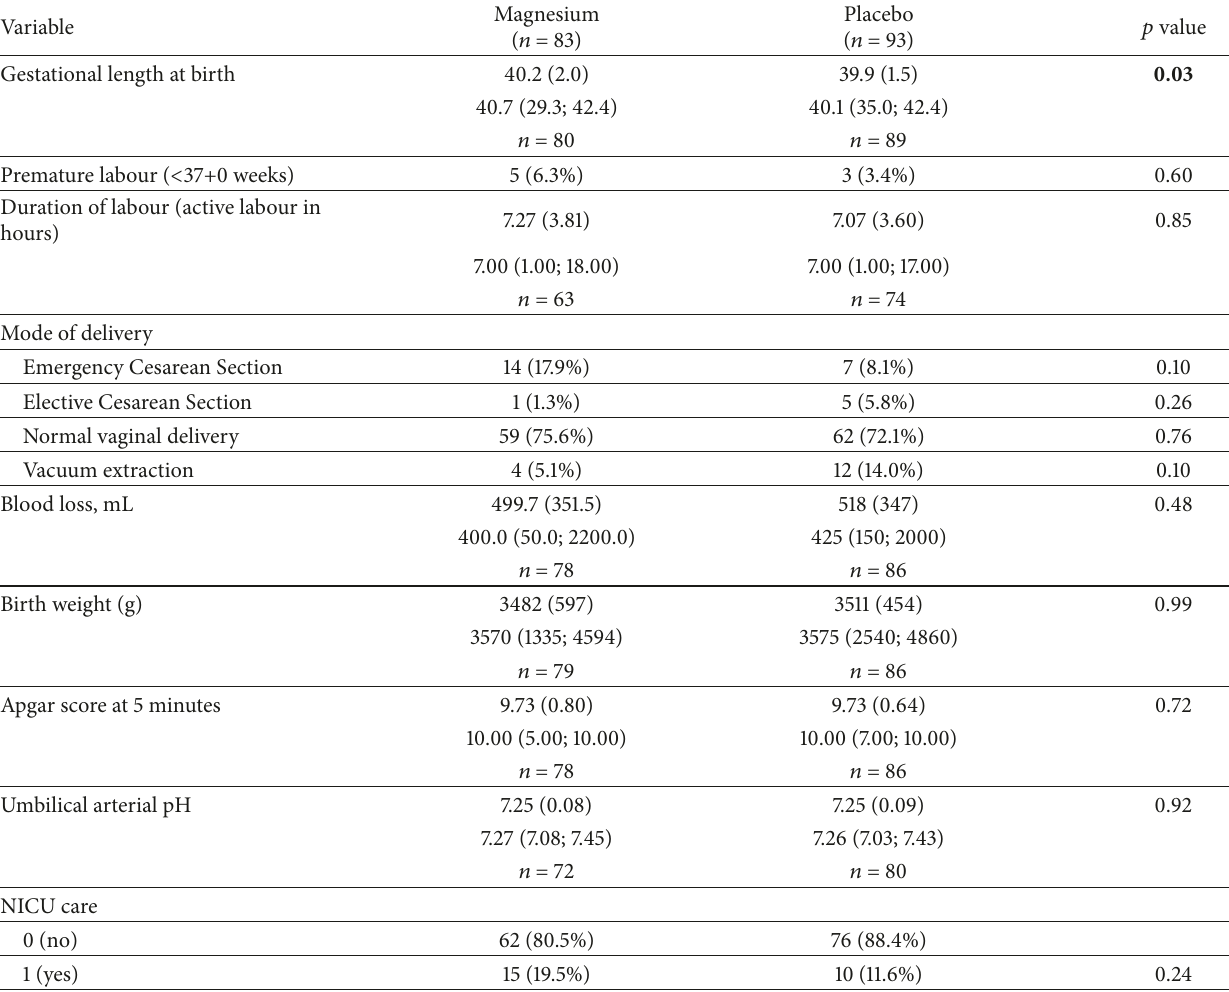
Table 3: Labour and fetal outcomes. Missing results are due to labour at other hospitals and no access to medical records (PP).